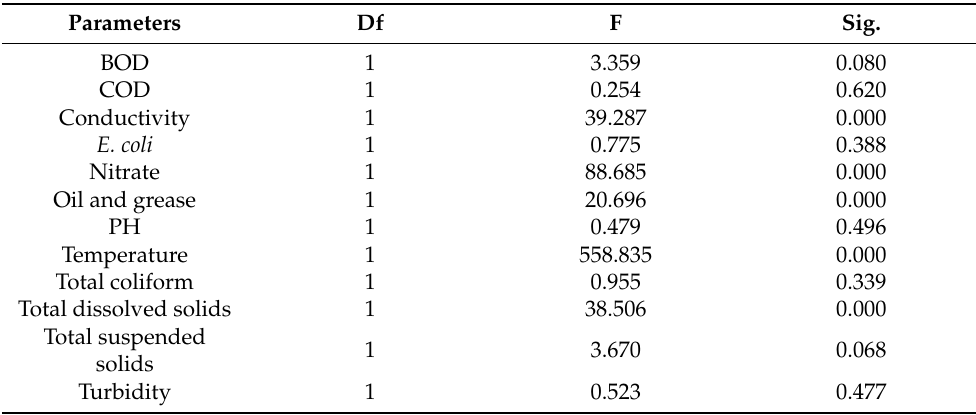
Table 3. One way ANOVA test for Ngong River for wet and dry